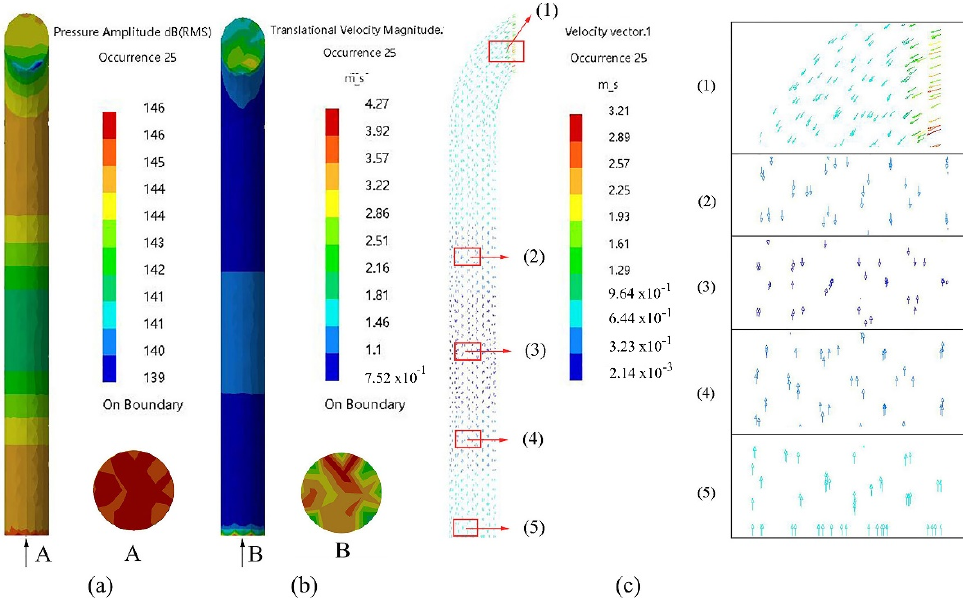
Figure 18. Vorticity amplitude nephogram ( a ) prototype ( b ) bionic tailpipe. Prototype: ( a ) sound pressure level amplitude nephogram, ( b ) velocity amplitude nephogram, and ( c ) velocity vector diagram.